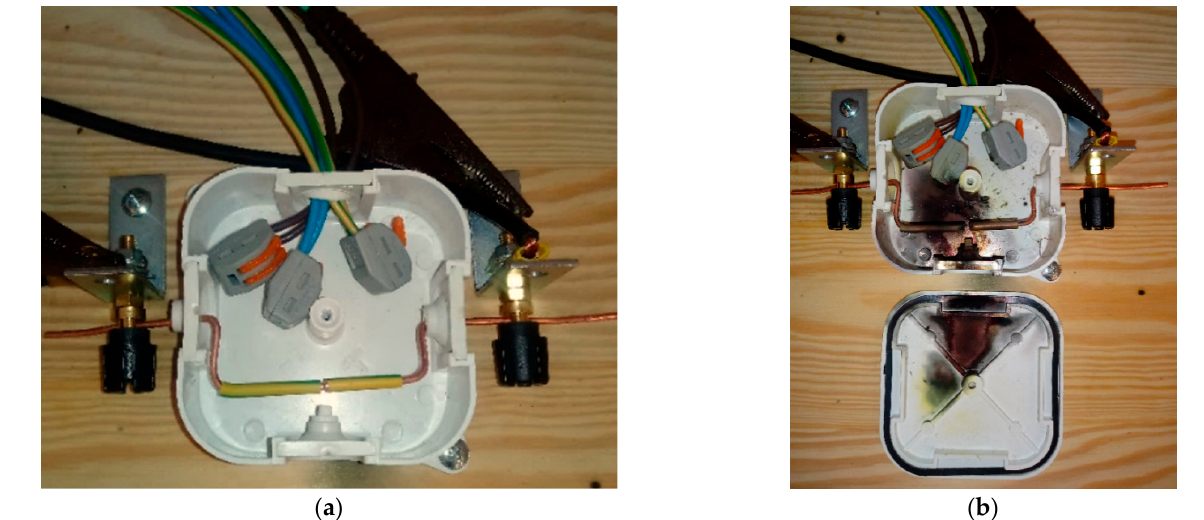
Figure 6. View of the inside of the electrical junction box before ( a ) and after ( b ) the arc fault test; supply voltage 230 V; the arc current 1000 A; the electric arc duration time 8.9 ms.